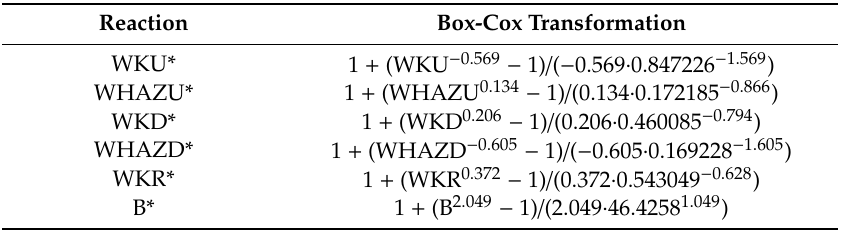
Table 2. Box-Cox transformation.